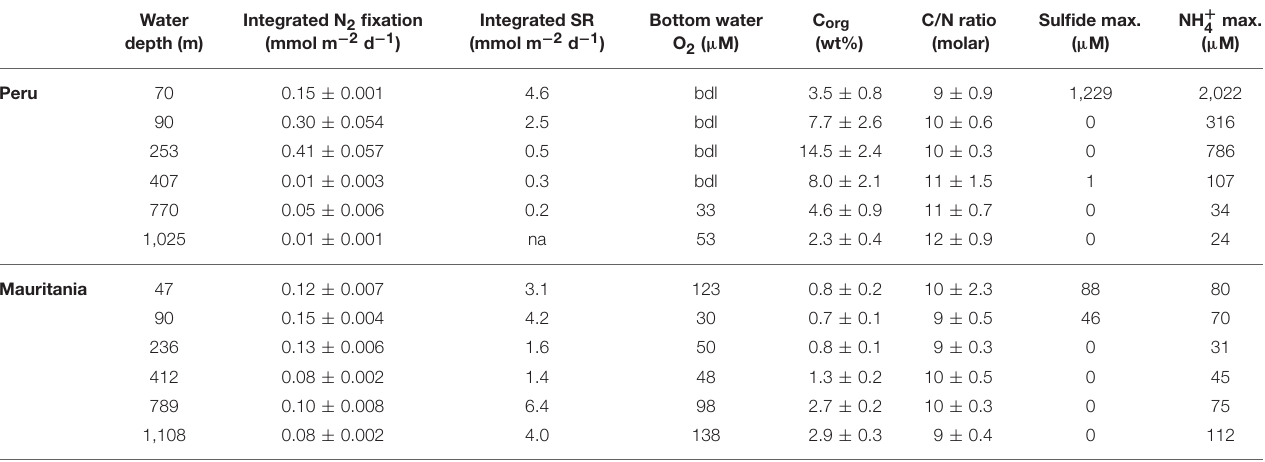
TABLE 3 | Integrated (0–20 cm) rates of N 2 fixation and sulfate reduction (SR) from 0 to 20 cm from this study compared to the Peruvian OMZ (from Gier et al., 2016) as well as environmental parameters. Water depth